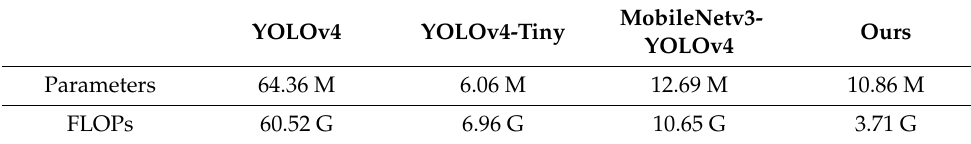
Table 8. Results of complexity comparison.